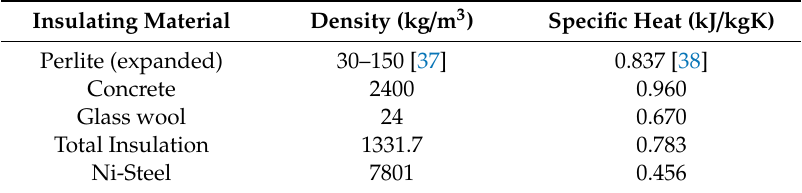
Table 1. Density and specific heat capacity of the insulation materials used in heat leakage calculations.